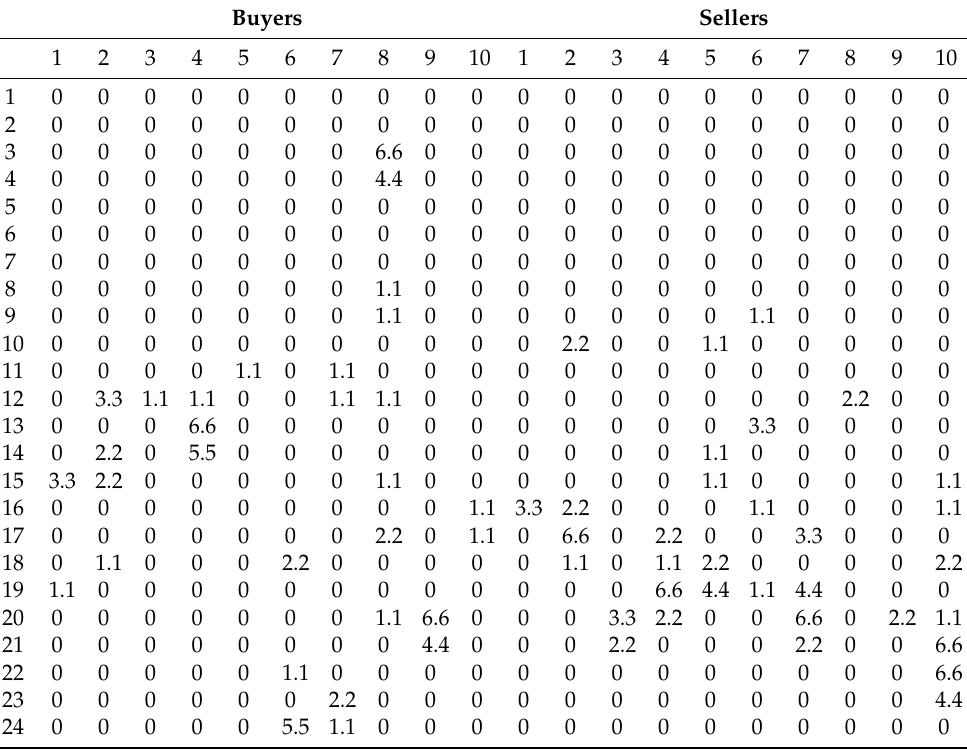
Table A1. Partial data of buyers’ charging/sellers’ discharging